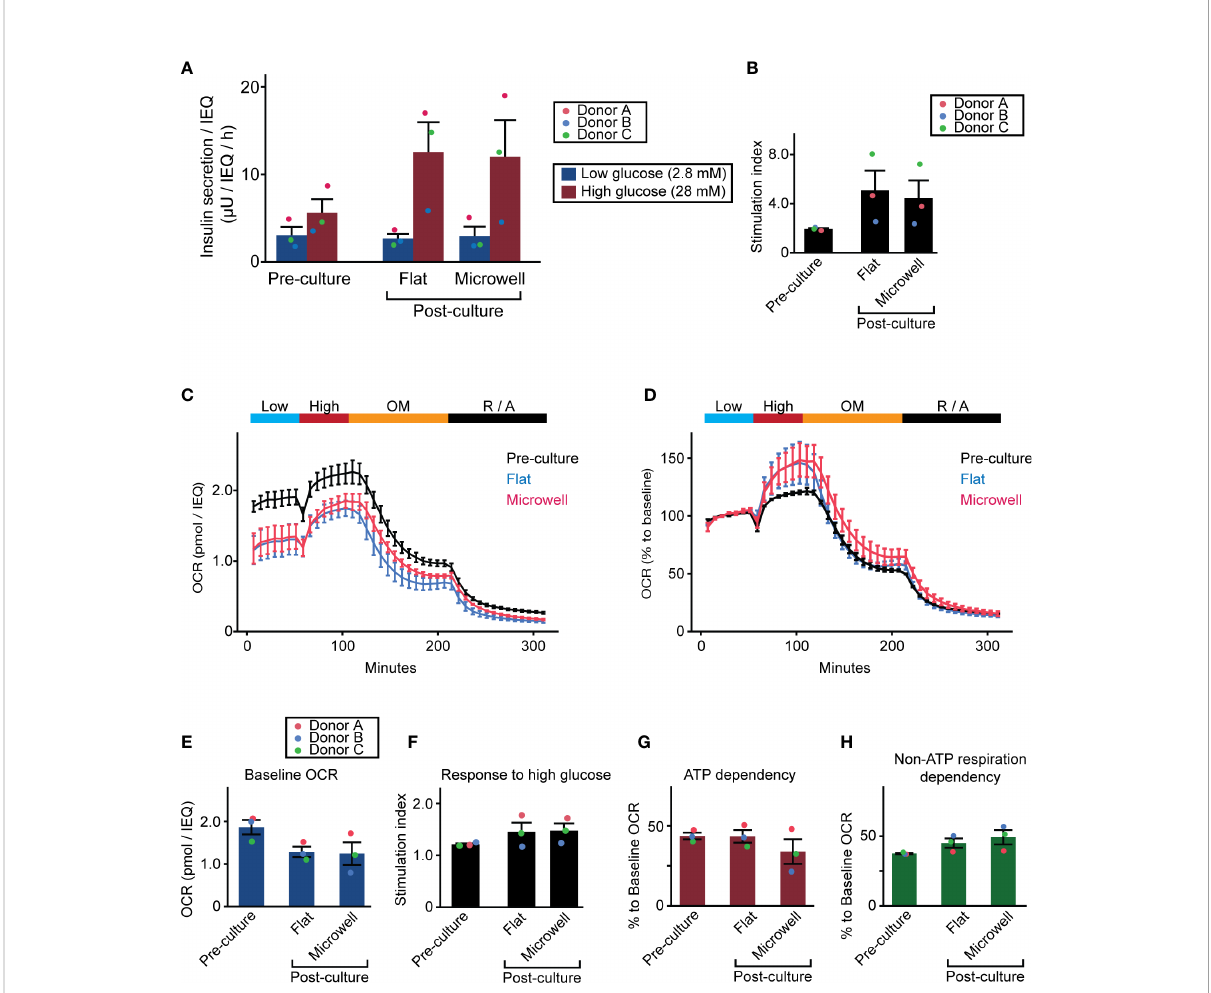
FIGURE 6 Insulin-secreting function and metabolism of two week-cultured human islets. (A) Glucose-stimulated insulin secretion assay was performed with 1 hour of low glucose exposure followed by 1 hour of high glucose exposure. Insulin secretion was normalized by the islet number (IEQ) applied. Data of pre- and post-cultured ( fl at dish and microwell dishes) islets are presented. n = 3 donors. Data of each donor is plotted in different color dots (red, blue and green for Donors A, B and C, respectively). (B) Stimulation index calculated as the ratio of high insulin secretion over low insulin secretion. (C) OCR assay with 4 solution phases with 1) baseline at 3 mM glucose, 2) glucose stimulation at 20 mM, 3) 5 µM oligomycin, and 4) 5 µM rotenone and 5 µM antimycin. n = 3 donors. Absolute OCR data was normalized by the islet number (IEQ) applied. Data plots are the average of 3 donors. Data of individual donor islets is available in Supplementary Figure 6. (D) OCR assay data analysis normalized to the baseline OCR. (E – H) Analyses of baseline OCR, response to high glucose, ATP dependency, and non-ATP respiration dependency in pre- and post-cultured ( fl at dish and microwell dishes) islets. Detailed method for the analysis is described in Supplementary Figure 2. Data of each donor is plotted in different color dots (red, blue and green for Donor A, B and C,